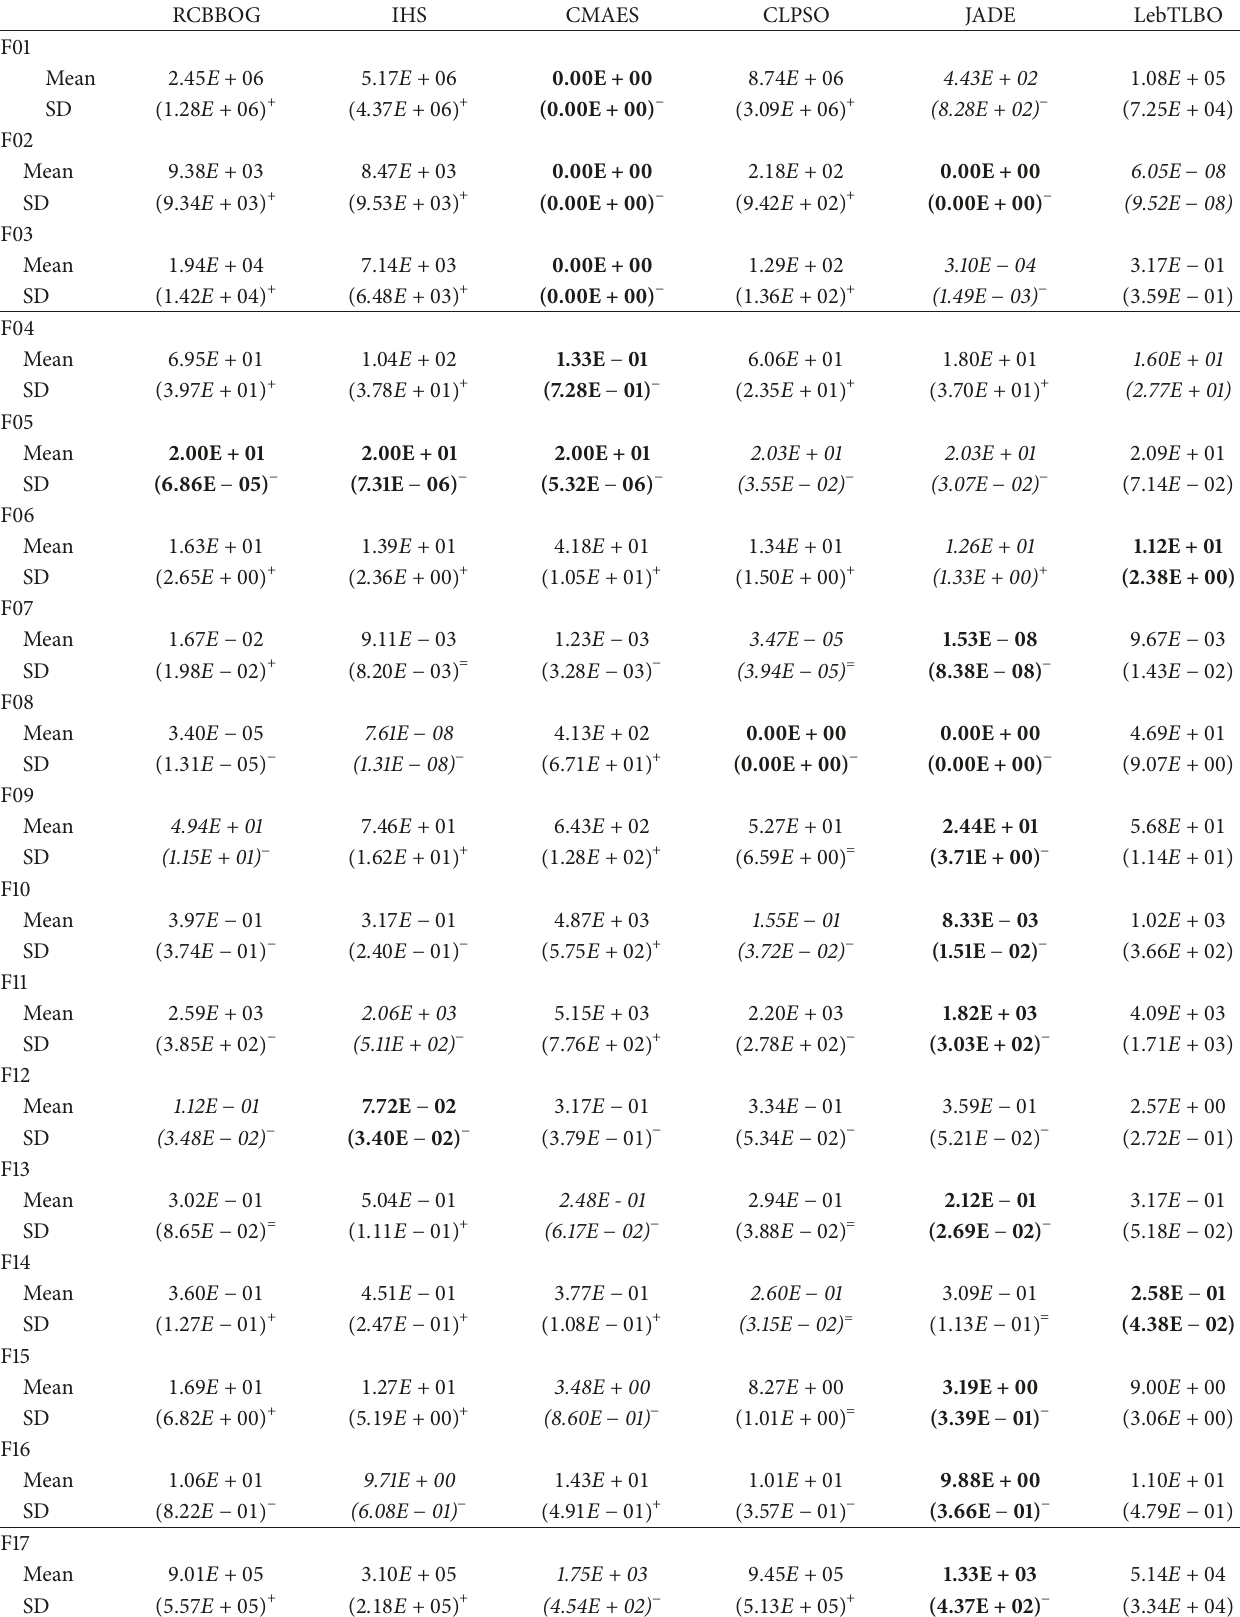
Table 5: Comparison between LebTLBO and other MS